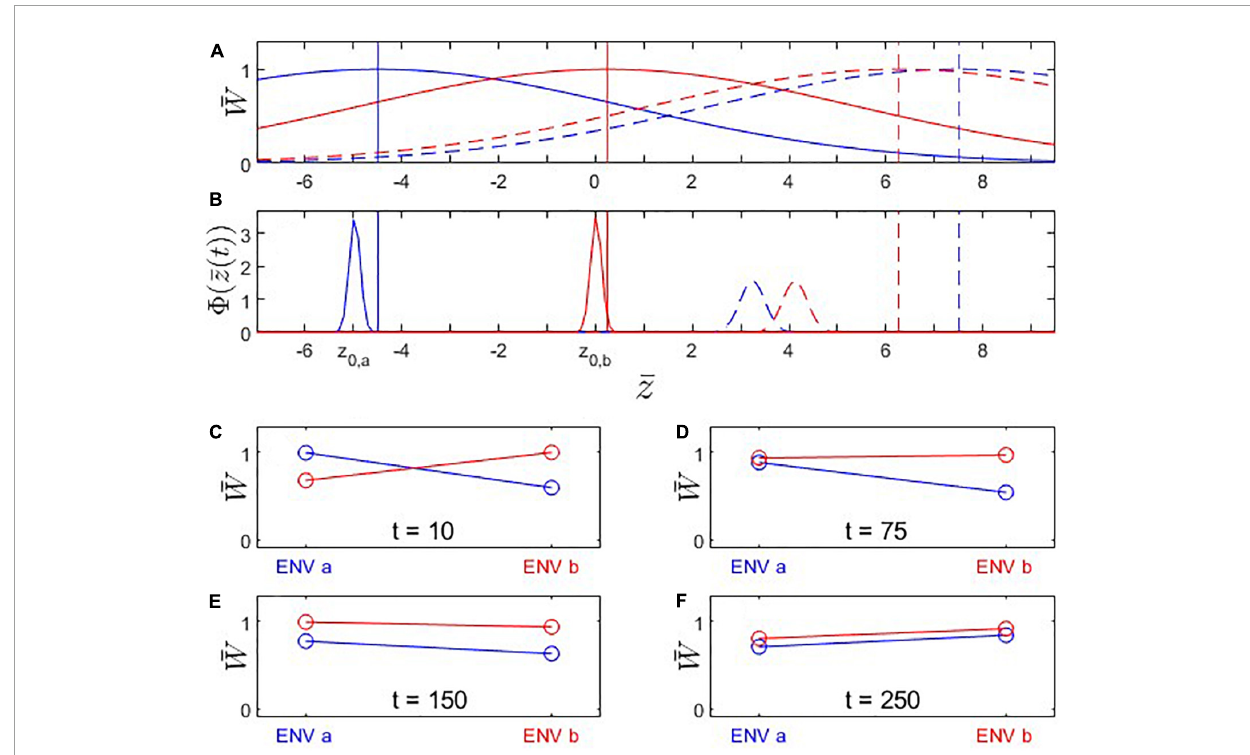
FIGURE5 Fitness landscapes, trait evolution and reciprocal transplant experiments under Scenario 3: Trait optima are moving (from left to right along the x-axis); initial trait values ¯ z 0 , a and ¯ z 0 , b are located at the fitness optima for their environments. Both populations adapt to the shifting environmental conditions but population A ’s (blue) fitness optimum moves faster than population B ’s (red). (A) Fitness landscapes for population A (blue) and population B (red) at t = 10 (solid) and t = 250 (dashed); vertical lines: fitness optima. (B) Distributions of phenotypic means at t = 10 (solid) and t = 250 (dashed). Note that both populations are trailing their respective fitness optima. (C–F) Fitness plots for hypothetical reciprocal transplant experiments performed at t = 10, 75, 150, 250. Parameters: k a = 0 . 050; k b = 0 . 025; ¯ z 0 , a = − 5; ¯ z 0 , b = 0; other parameters as in Figure 1